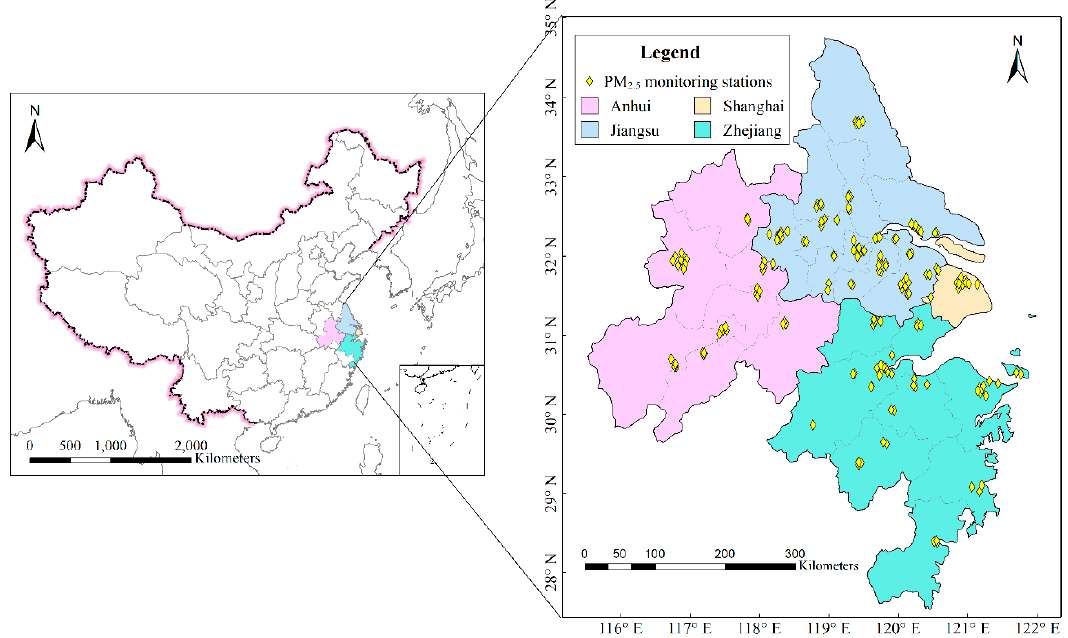
Figure 1. Study area and the spatial distribution of ground monitoring stations.